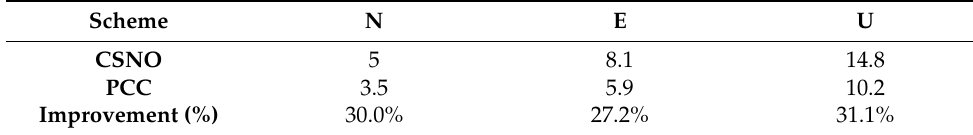
Figure 13. The station U-direction RMS for BDS-only PPP solutions of CSNO and PCC Schemes. Table 7. BDS-only PPP RMS of each scheme and their comparison, the unit is mm. Scheme